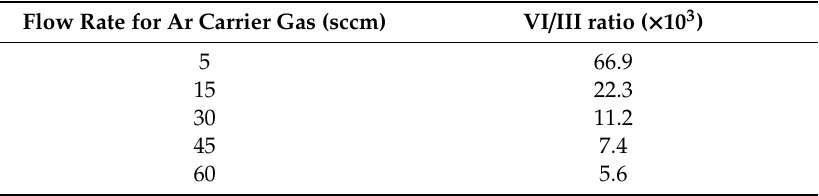
Table 1. The VI / III ratios at various flow rates of Ar carrier gas.